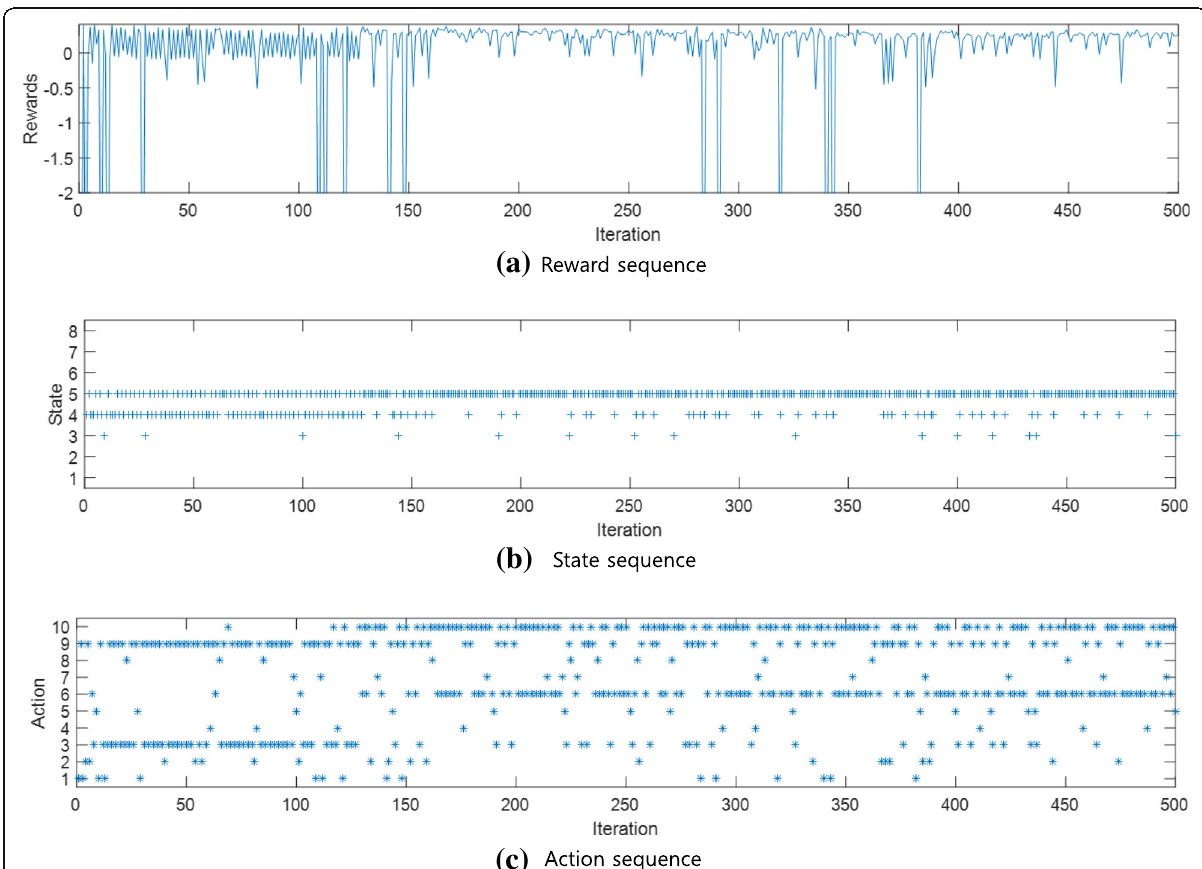
Fig. 14 Rewards, states, and actions according to iteration at DDR = 90 kbps. In a, the reward is stable at more than 10 iterations, and we can see that the reward is temporally low in the overall interval by random action, similarly to Fig. 12. As shown in b the agent mainly visits the state 5. c Reveals that actions in band group 2 are selected